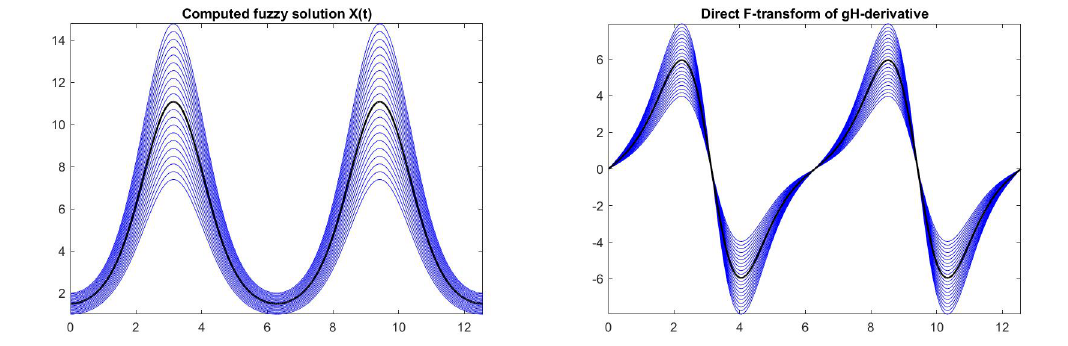
Figure 15. Problem FDE2, Meth = 1: gH-differentiable solution ( left ) and its gH-derivative ( right ). There are three switching points, in the same position for all α -cuts.